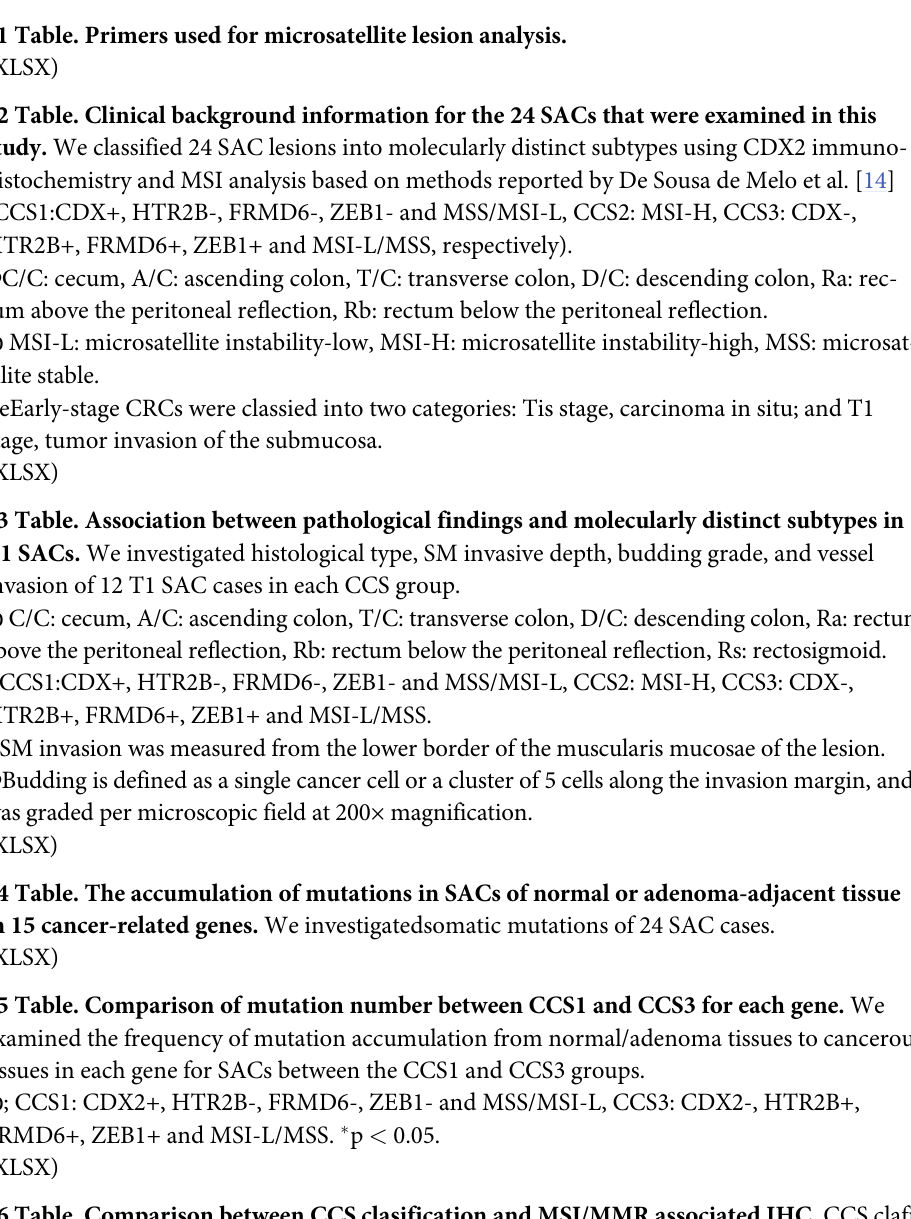
S6 Table. Comparison between CCS clasification and MSI/MMR associated IHC. CCS clafi- cication distincted by immunohistochemistry of CDX2, HTR2B, FRMD6, and ZEB1, and MSI